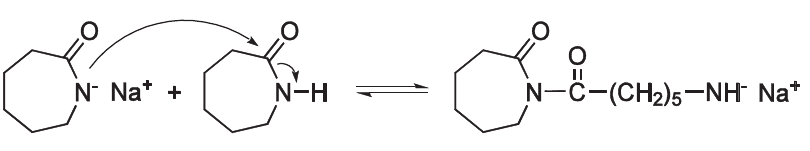
Figure 43. The opening of a lactam ring by a lactam